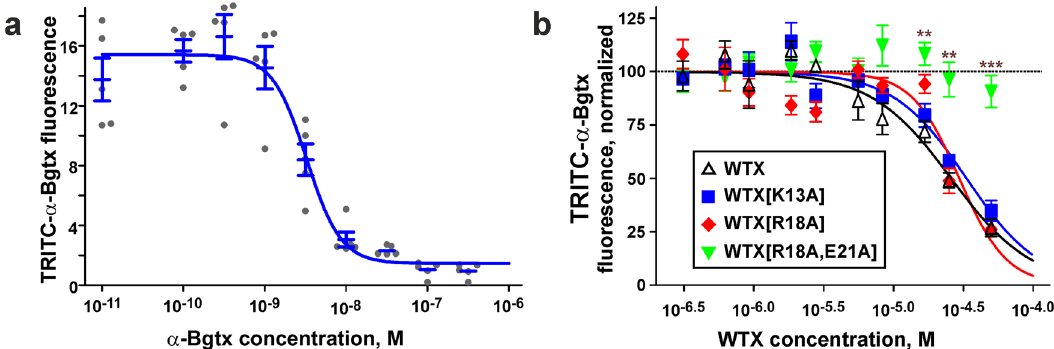
Fig. 6 Competition of α -Bgtx and WTX and its mutants with TRITC-labeled α -Bgtx for binding to α 7-nAChR expressed in HEK293 cells. a Data on competition of α -Bgtx with TRITC-labeled α -Bgtx presented as median fl uorescence intensities (MFI) ± SEM ( n = 5 independent experiments). The Hill equation ( y = A 0 + A 1/(1 + ([Toxin]/IC 50 ) nH )) was fi tted to data. b Data on competition of WTX and its mutants with TRITC-labeled α -Bgtx were normalized to the TRITC- α -Bgtx-binding in absence of WTX or its mutants and shown as mean ± SEM ( n = 5 independent experiments). The Hill equation ( y = 100%/(1 + ([Toxin]/IC 50 ) nH )) was fi tted to normalized data. Individual datapoints for this dataset are given in Supplementary Fig. 9. ** p < 0.01 and *** p < 0.001 indicate the signi fi cant difference between WTX and WTX[R18A, E21A] groups by two-sided t -test with Holm-Sidak correction for multiple